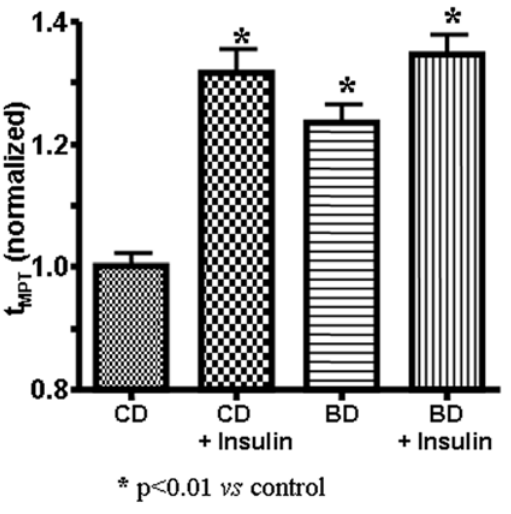
Figure 1. Cellular mechanism of cardioprotection. Blueberry- enriched diet reduces the MPT susceptibility to ROS (t MPT ) in cardiac myocytes. The t MPT was measured in cells isolated from the hearts of rats, fed for 3 months a control (CD) or blueberry-enriched (BD) diet, before or after exposure to insulin 30 nM (as the positive control) for 20 min. * - p , 0.01 vs Control.